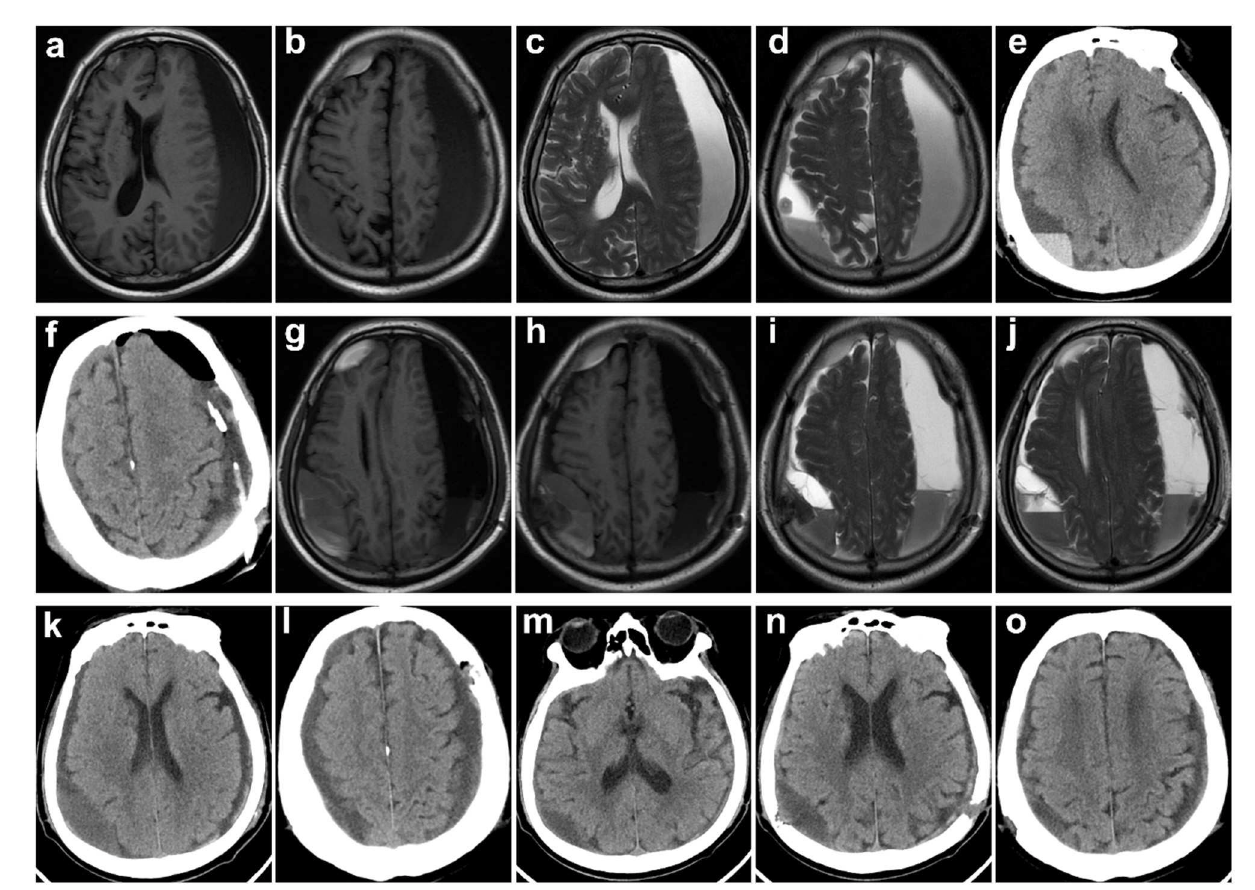
FIGURE3 Typical case 2. Images obtained from a 79-year-old man with bilateral cSDH from the HC group. (a–d) Preoperative T1-weighted and T2-weighted MR images. (e, f) CT reexamined the day after surgery showing that the midline of the brain returned to normal (symptoms of hemiparesis and speech arrest were relieved), yet part of blood products and air remained. (g–j) MRI reexamination was given on the fifth day after the operation, because of impaired consciousness and the symptoms of hemiparesis and speech arrest reappeared. (k, l) Reoperation of burr-hole drainage was conducted. (m–o) A follow-up CT scan obtained 1 month later demonstrated resolution of cSDH, and symptoms were significantly